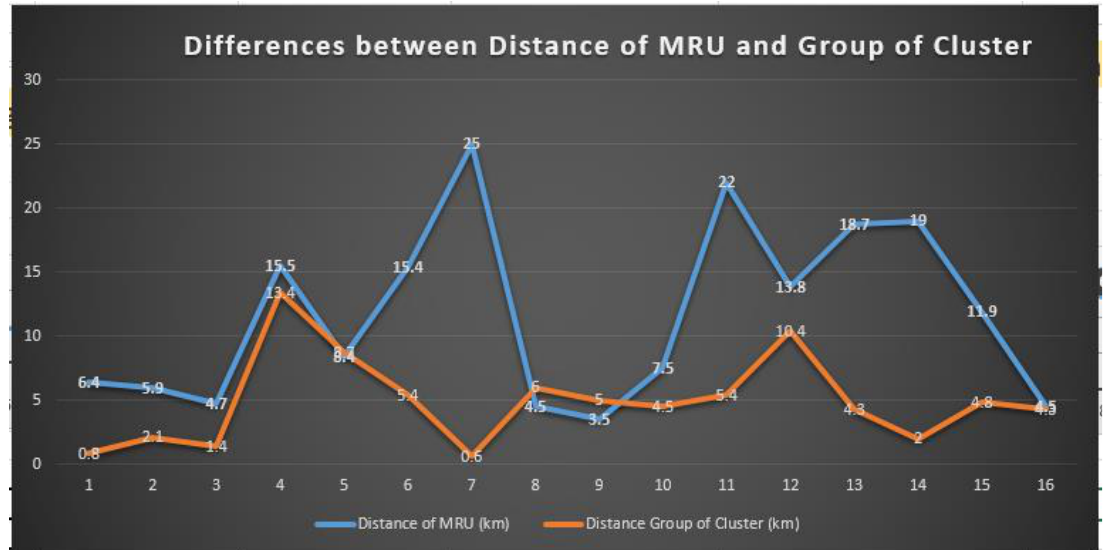
Figure10 Graph differences between distance of MRU and Group of Cluster